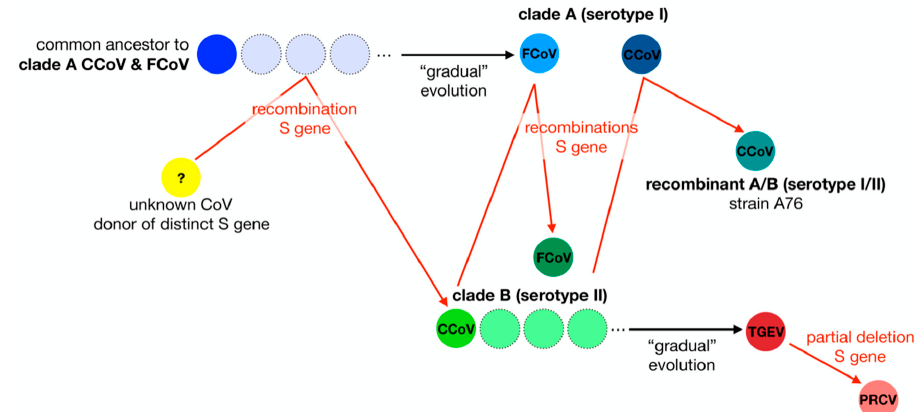
Figure 1. Diagram of the S gene flow within the Alphacoronavirus 1 species. In this schematic diagram the evolution of members of the Alphacoronavirus 1 species is summarized using a S gene-centric view. It is thought that clade A (serotype I) CCoV and FCoV share a common ancestor. A recombination event with an unknown coronavirus allowed the emergence of a clade B (serotype II) CCoV with a S protein distinct from clade A CCoV. Multiple independent recombination events led to the emergence of clade B (serotype II) FCoV and recombinant A/B (serotype I/II) CCoV. TGEV is believed to have emerged from clade B CCoV. Partial deletion of the N-terminal domain of the S protein of TGEV gave rise to